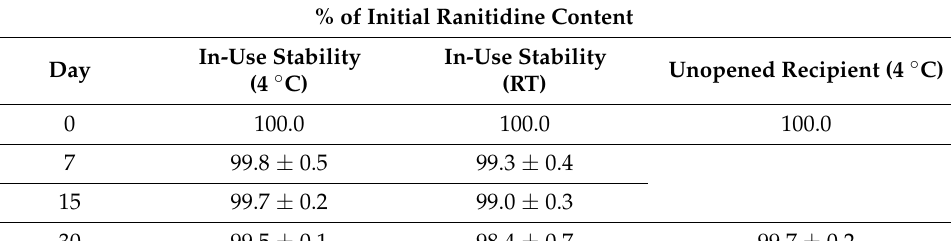
Table 2. Results of the chemical stability of the oral pediatric ranitidine 25 mg/mL solution. (Mean ± standard deviation, n = 3).